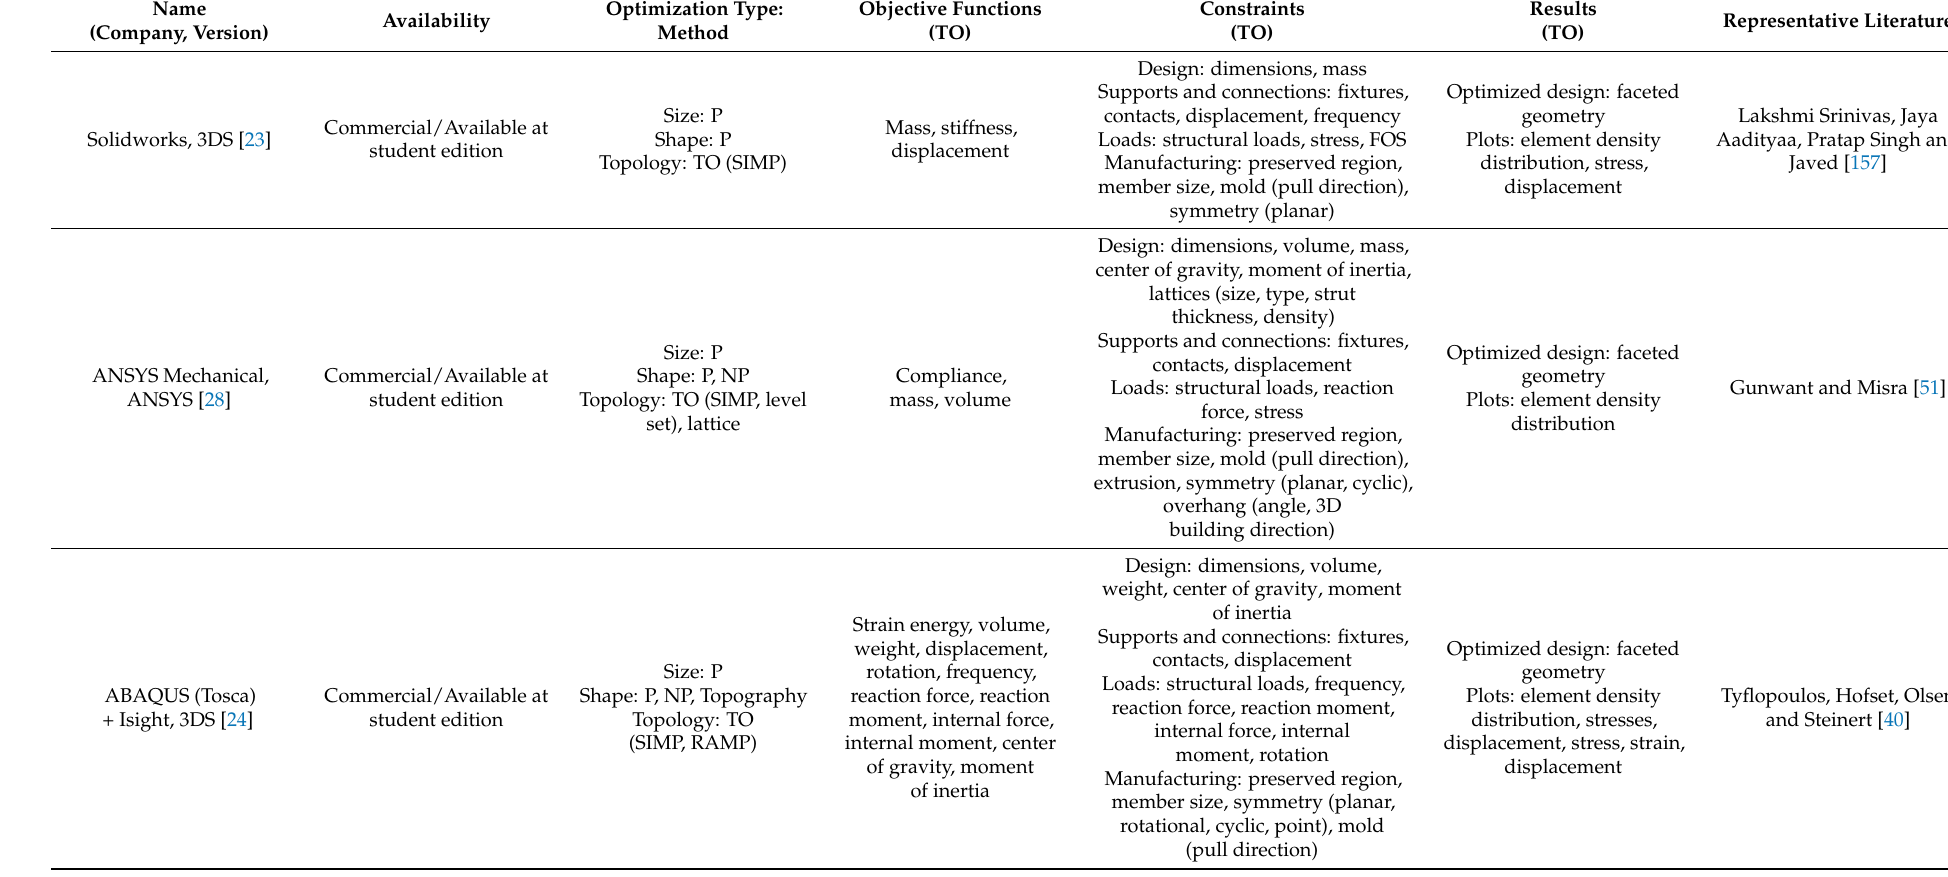
Table 1. A section of the table containing the TO